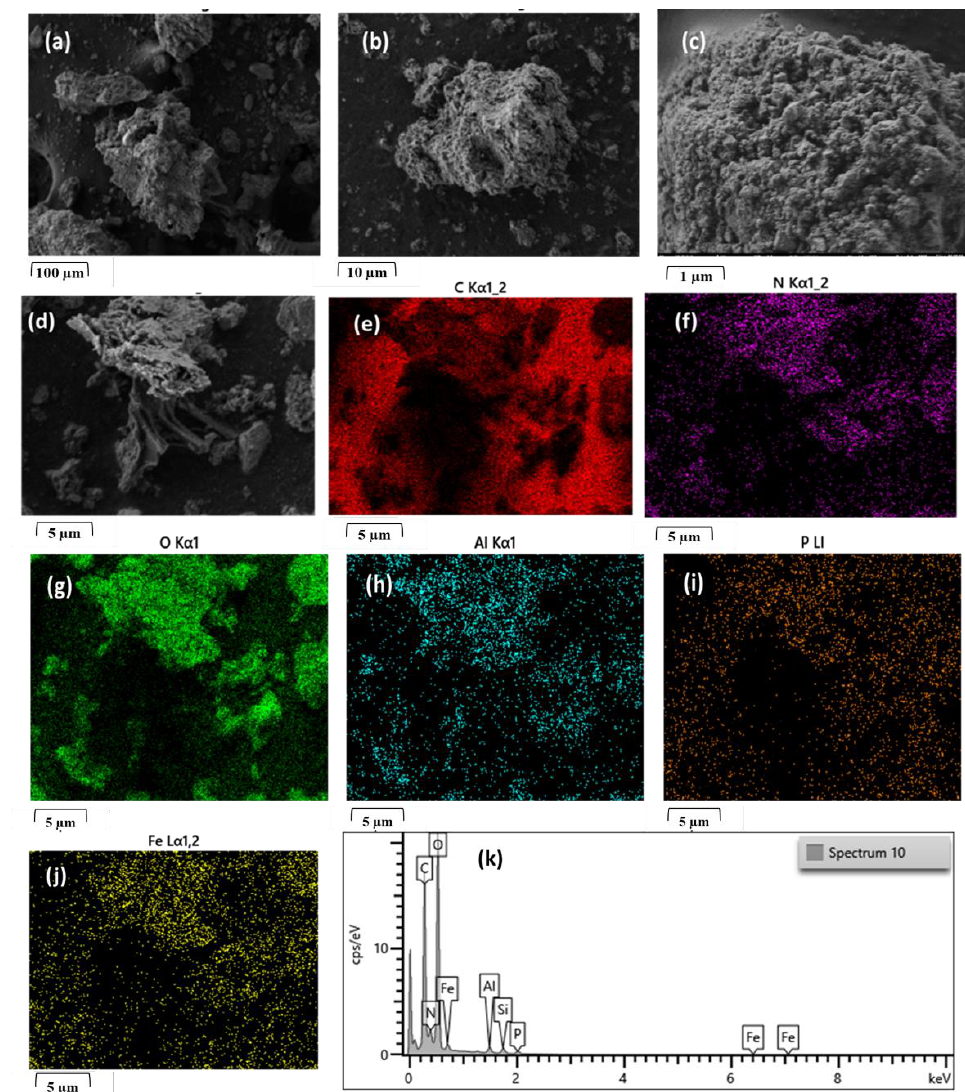
Figure 5. ( a – c ) SEM images of biochar; SEM image ( d ) and elemental distribution of C ( e ), N ( f ), O ( g ), Al ( h ), P ( i ), Fe ( j ), and ( k ) EDS spectrum of biochar.